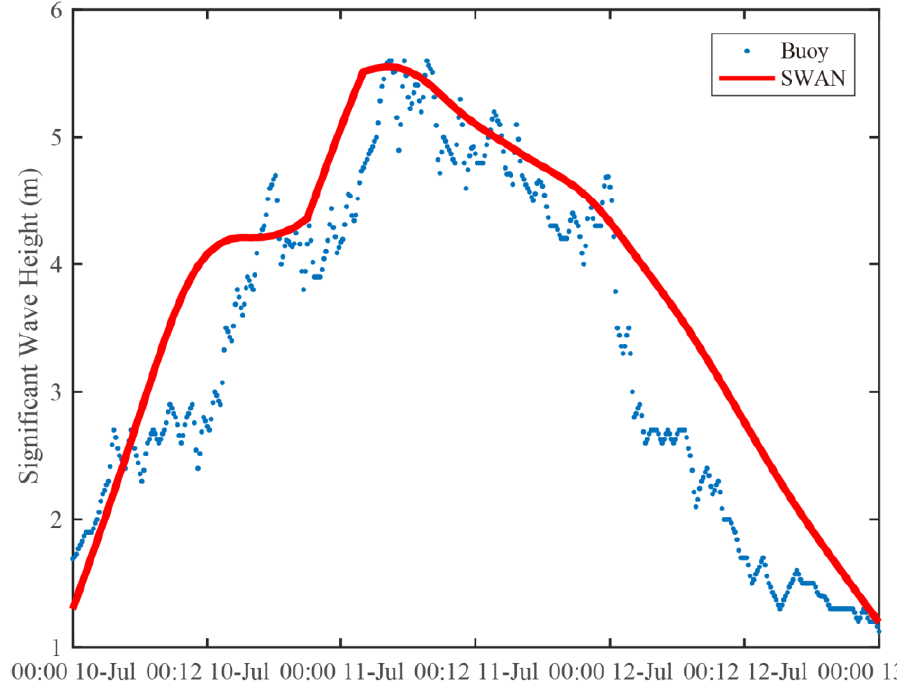
Figure 13. Comparison between significant wave heights simulated by the SWAN model and those recorded from the buoy B14 during Typhoon Chan-hom.